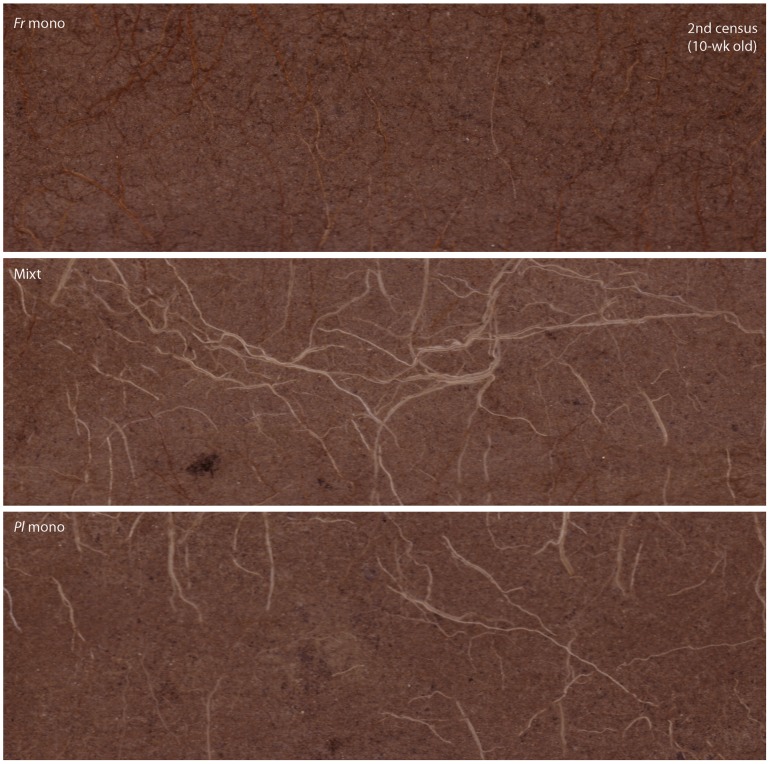
Minirhizotron images at 10 cm depth taken ten weeks after the start of the experiment.Note the abundance of P. lanceolata (Pl, white roots) and absence of F. rubra (Fr, brown roots) in mixtures images compared to the respective monocultures.